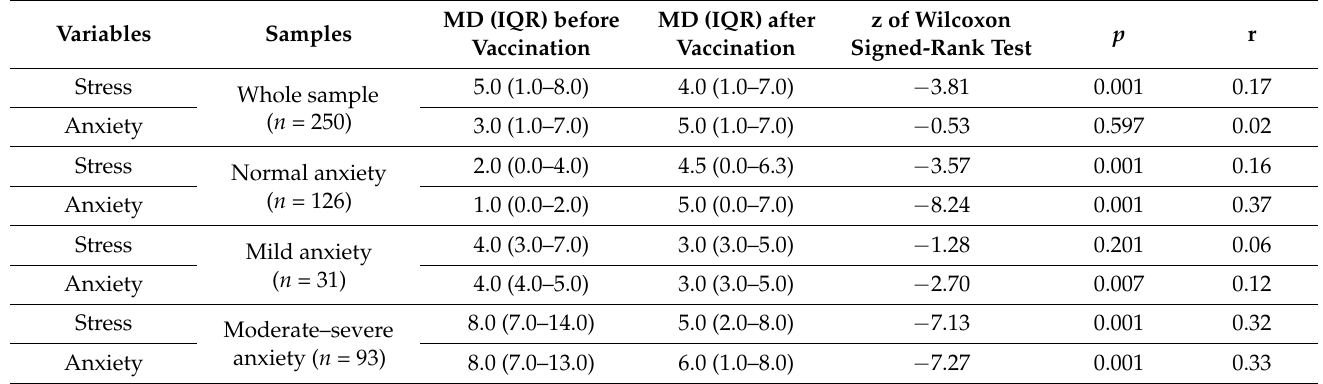
Table 3. Descriptive statistics of stress and anxiety symptoms among the respondents and differences in the levels of stress and anxiety before and after the administration of the first dose COVID-19